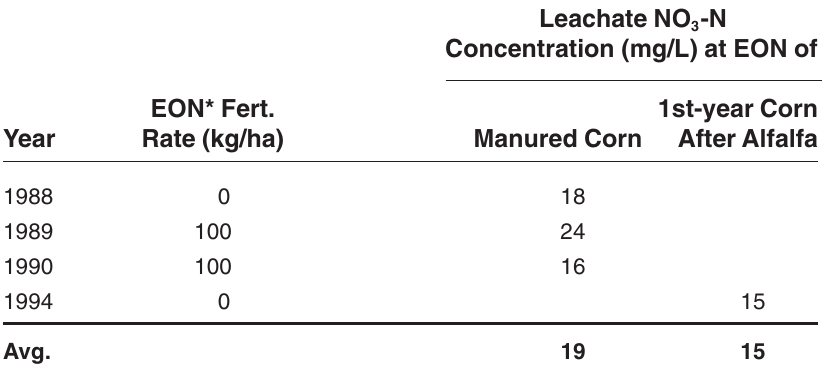
Leachate NO -N 3